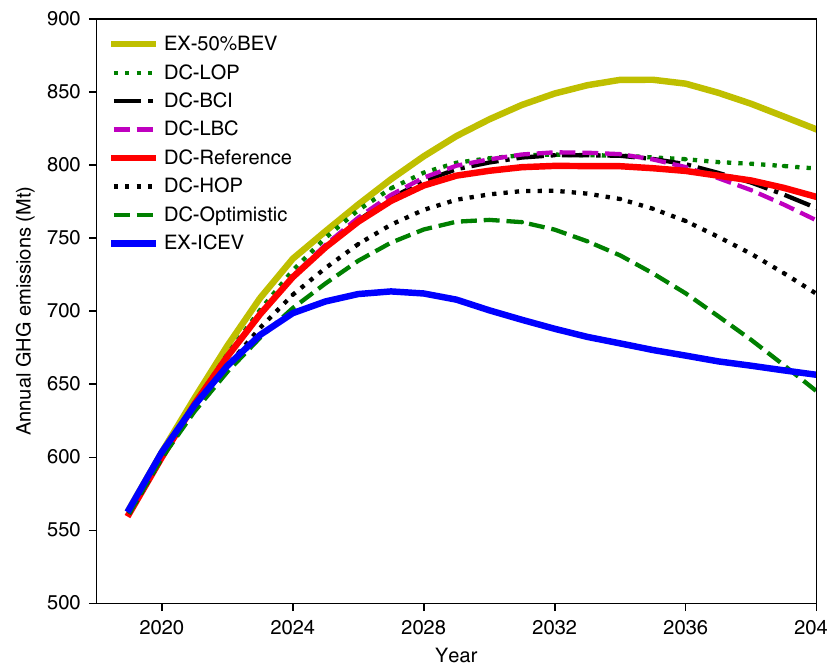
Fig. 3 Annual life-cycle GHG emissions of LDPV fl eet in China under various externalities, compared with two extreme scenarios. EX-50%BEV: extreme scenario with 50% BEV sales share by 2030; DC-LOP: Dual Credit + low oil price; DC-BCI: Dual Credit + better charging infrastructure; DC-LBC: Dual Credit + low battery cost; DC-Reference: Dual Credit policy reference scenario; DC-HOP: Dual Credit + high oil price; DC-optimistic: Dual Credit + HOP + LBC + BCI; EX-ICEV: extreme scenario by aggressively improving ICEV ef fi ciency.